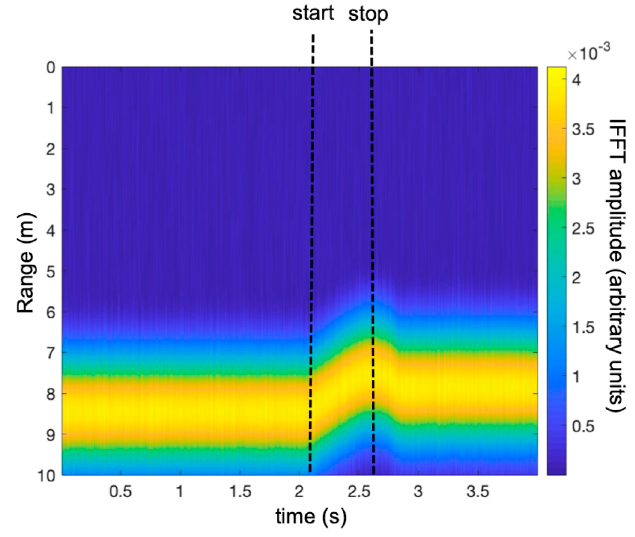
Figure 6. Simulated time-range map of the free-falling target.